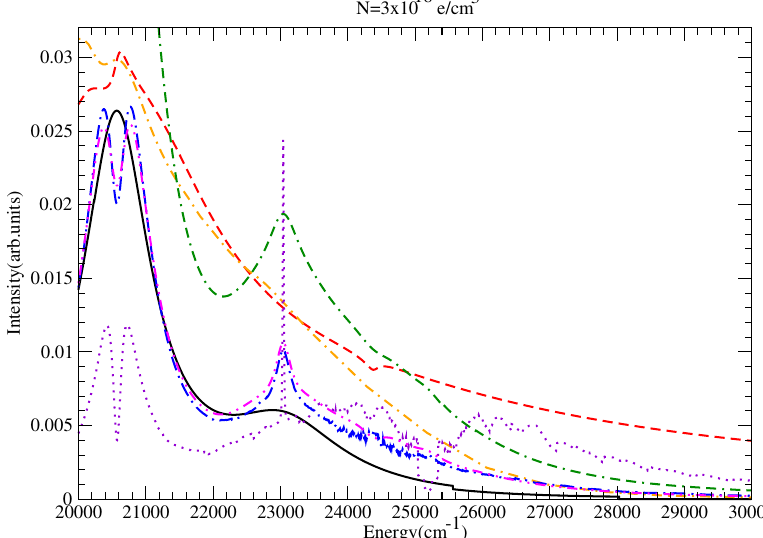
Figure 21. The region including H β and beyond at the highest density showing a very good agreement between QC-FFM and CONVPST up until H γ . Shown are QC-FFM (solid), PPP (dashed), DWE (dash-dotted), CONVST without strong collisions (dotted), CONVST with strong collisions (dot-double dashed), CONVPST without strong collisions (long dash-dotted) and CONVPST with strong collisions (dash-double